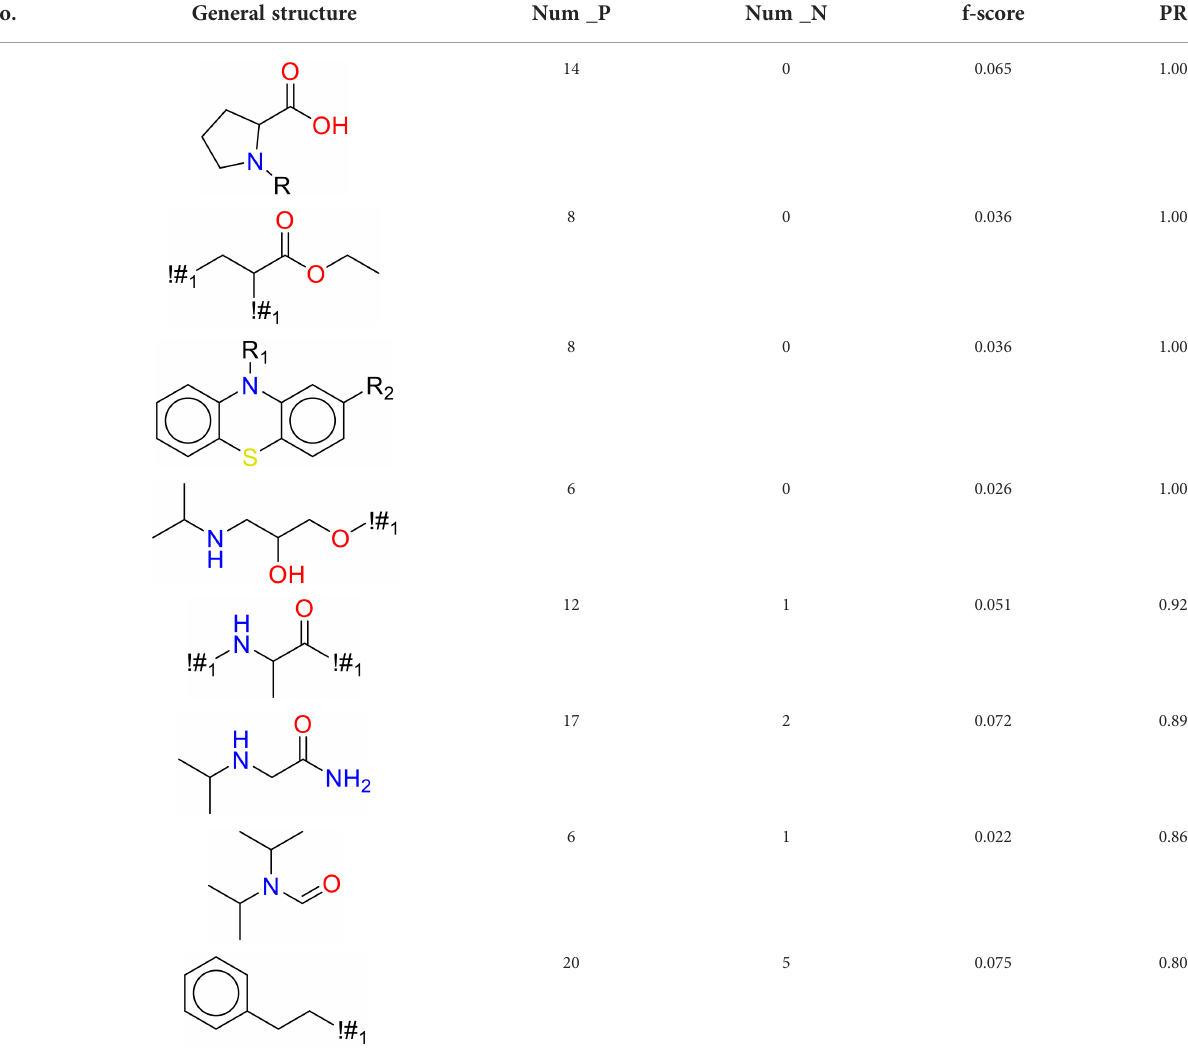
TABLE 5 Structural alerts responsible for chemical DIAD toxicity detected from KRFP fragments.